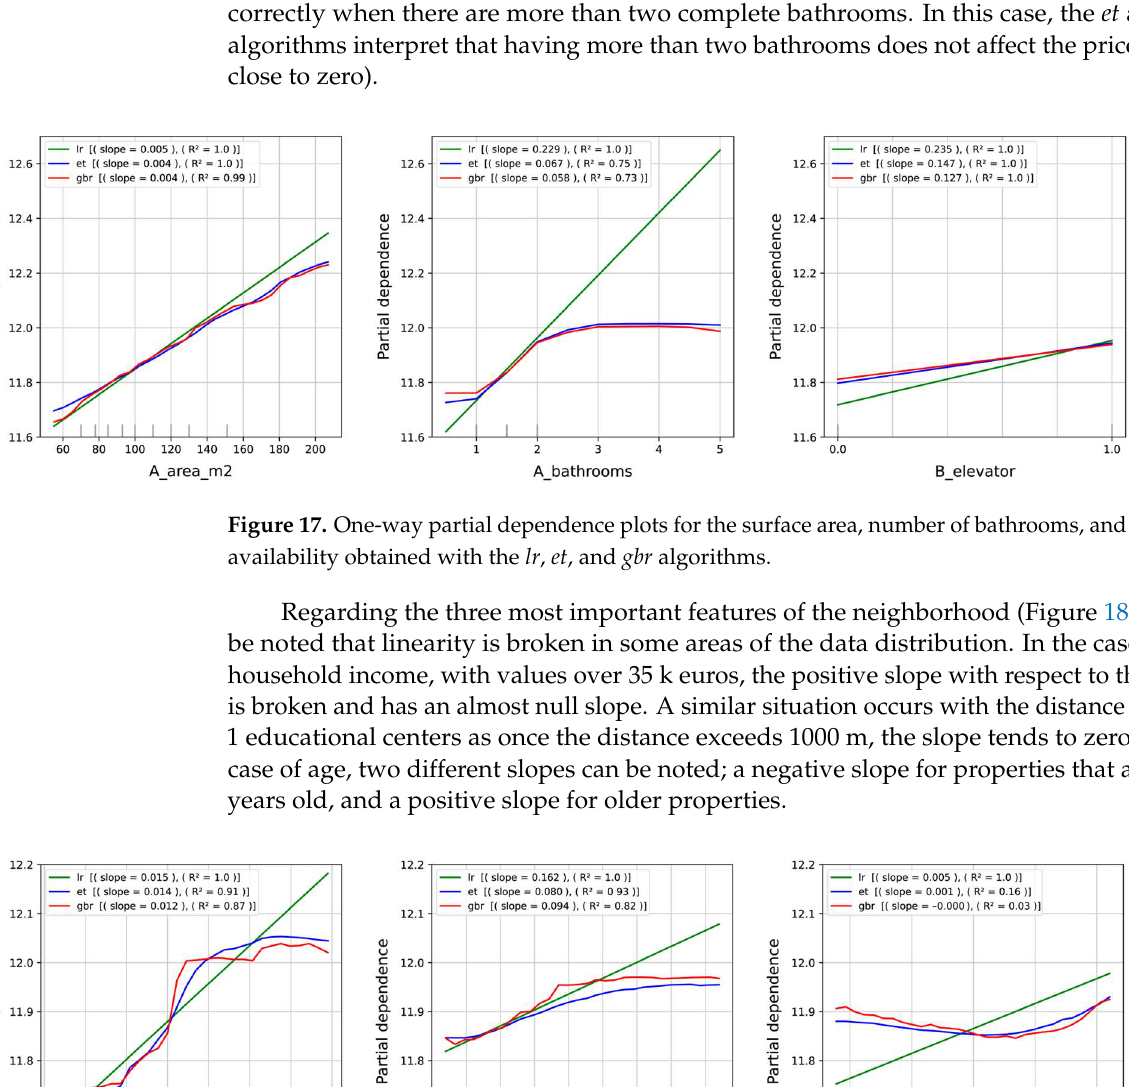
Figure 16. ( a ) One-way partial dependence plots for X and Y coordinates with lr , et , and gbr algo- rithms. ( b ) Two-way directional partial dependence plots for lr , et , and gbr algorithms. The partial dependence plots for the most important property features are shown in Figure 17. Floor area and the availability of an elevator show the same trend in all three algorithms. Regarding floor area, it must be considered that the graph is cut off at 210 m², which leaves larger properties in that 2.5% of extreme cases that can distort the represen- tation. Regarding bathrooms, it can be noted that the lr model does not predict correctly